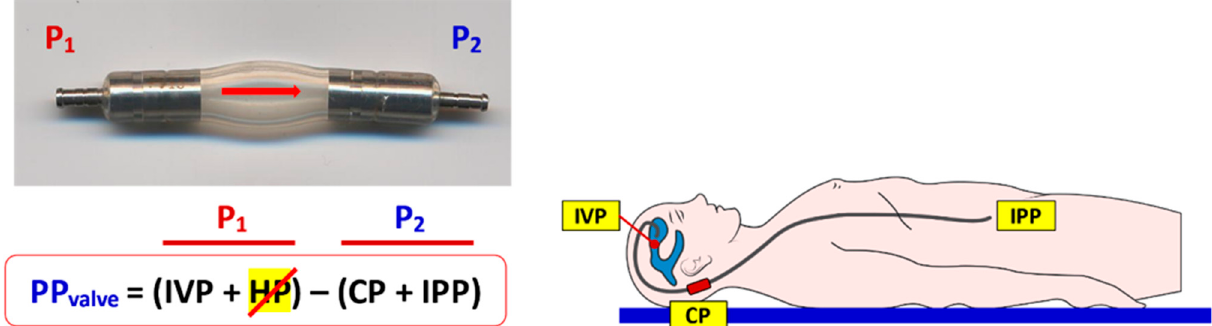
Figure 2. ( Top ). In this figure, the pressures defining the perfusion pressure of the valve (PP valve ) are shown. P 1 is the pressure at the inlet of the valve and P 2 at the outlet. P 1 is the sum of the intraventricular pressure (IVP) and the gravitational-induced hydrostatic pressure (HP). P 2 is the sum of the closing pressure (CP) of the valve and the intraperitonal pressure (IPP) if the distal catheter is placed in the peritoneum or the intra-atrial pressure (IAP) if the distal tip is placed within the right atrium. ( Bottom ). When the shunted patient is recumbent, the hydrostatic difference between the tips of the ventricular and intraperitoneal catheters is negligible and ~0 mmHg; therefore, the HP in the equation that calculates the PP valve can be removed.